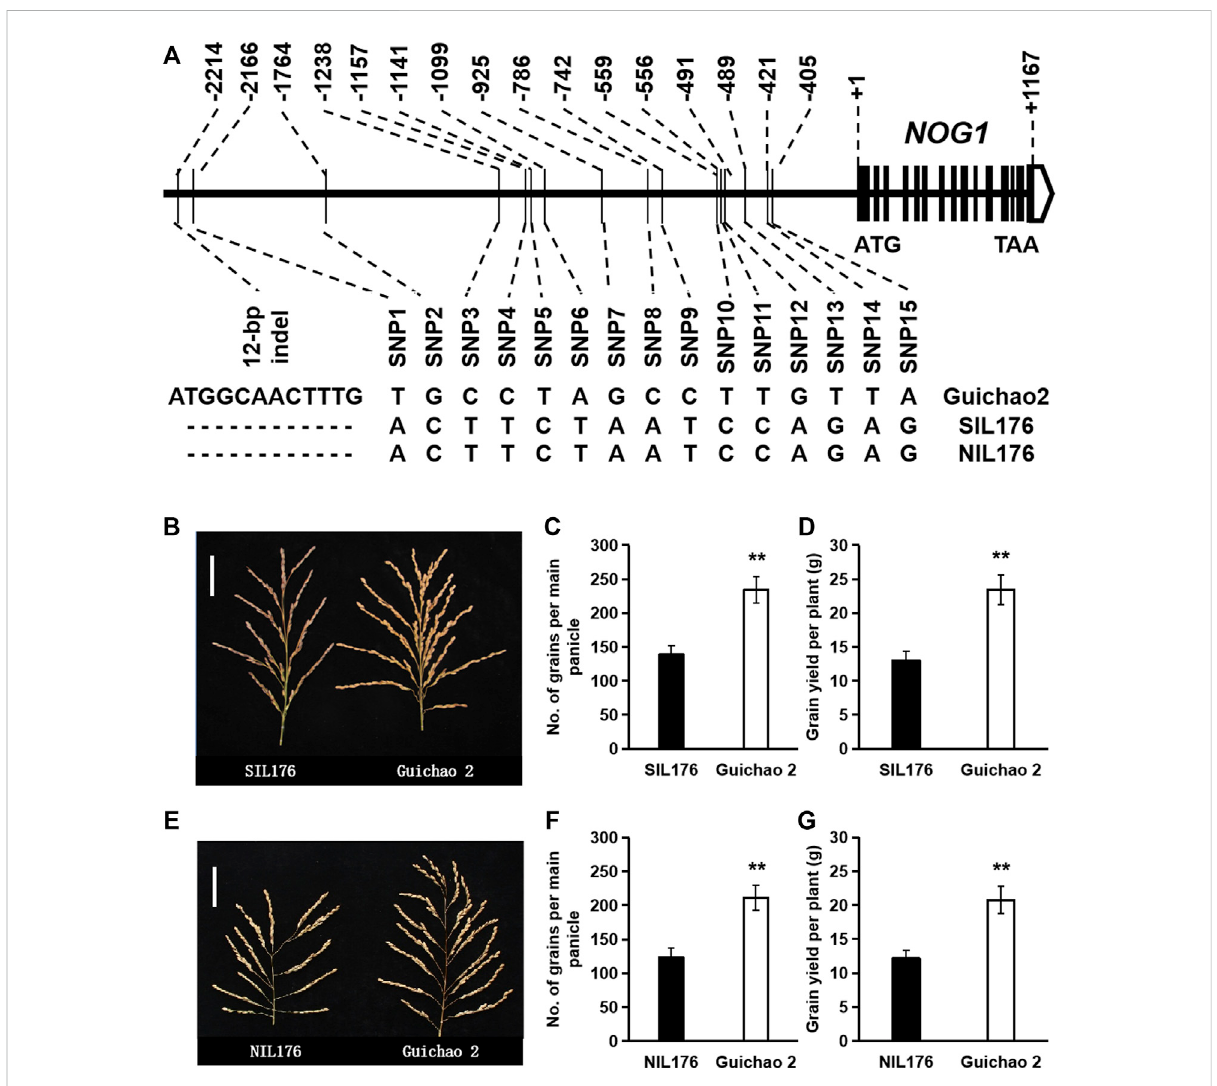
FIGURE 2 Genotypesandphenotypesofthe nog1 near-isogenicline. (A) :Genotypesofthe nog1 near-isogenicline(NIL176),SIL176andGuichao2. (B – D) : Phenotypic comparison between SIL176 and Guichao 2. (E – G) : Phenotypic comparison between NIL176 and Guichao